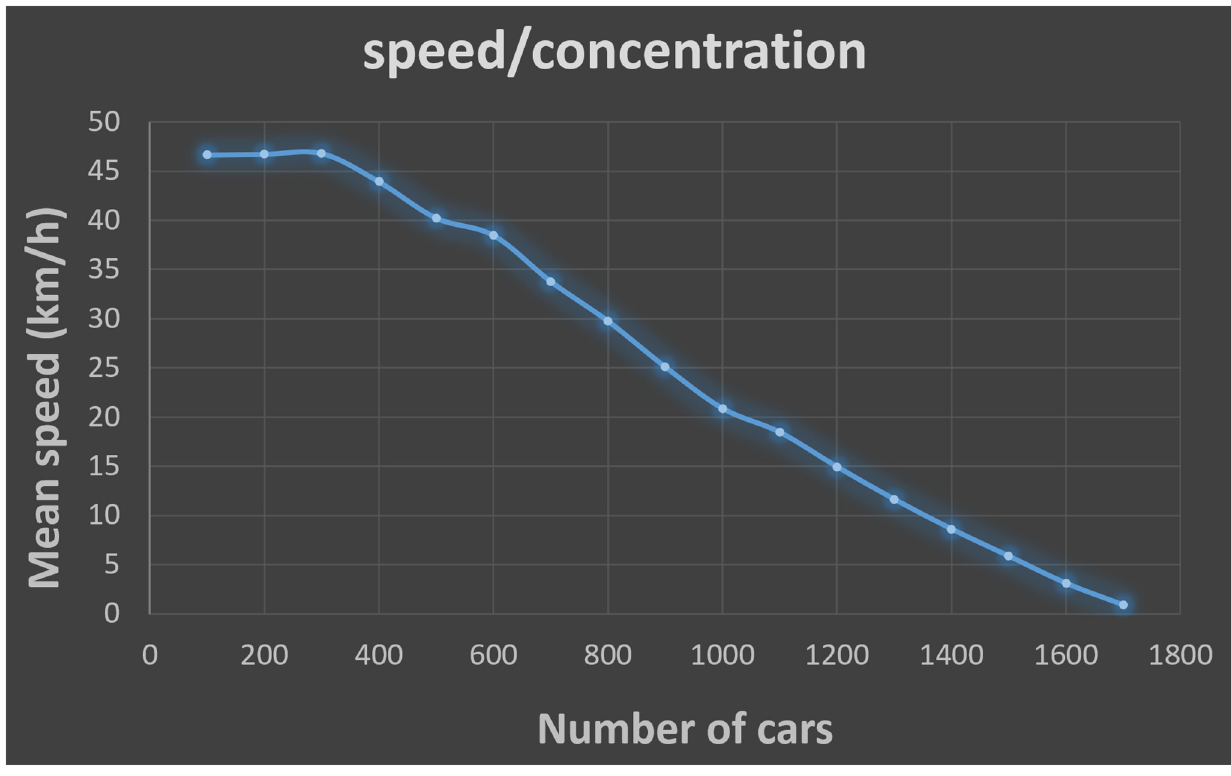
Fig 3. Average speed value according to the number of